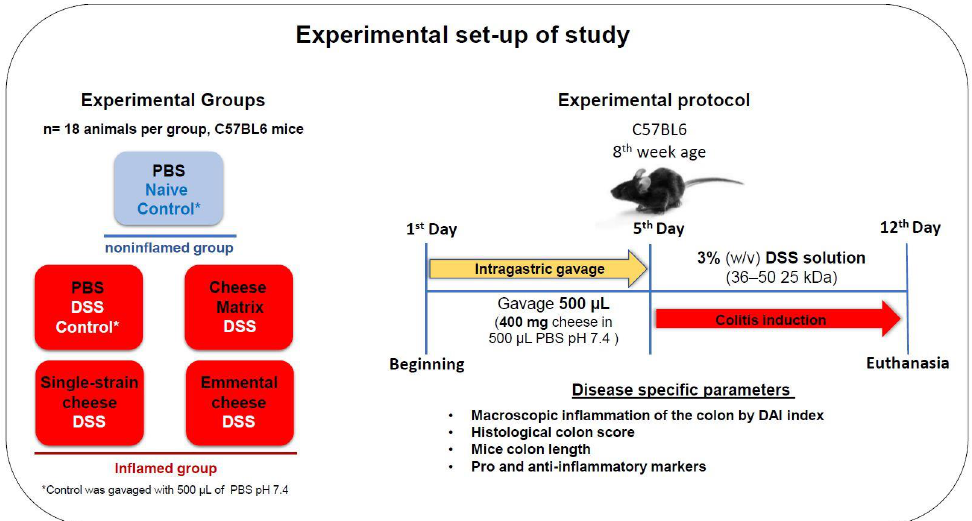
Figure 1. Experimental design of the evaluation of anti-inflammatory effects of a preventive implementing P. freudenreichii -fermented cheeses, in the context of DSS-colitis. C57BL6 mice